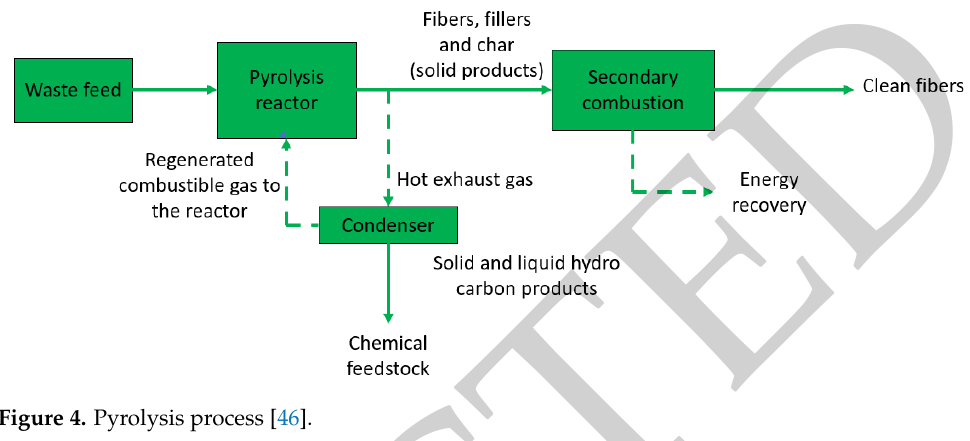
Figure 4. Pyrolysis process [46].